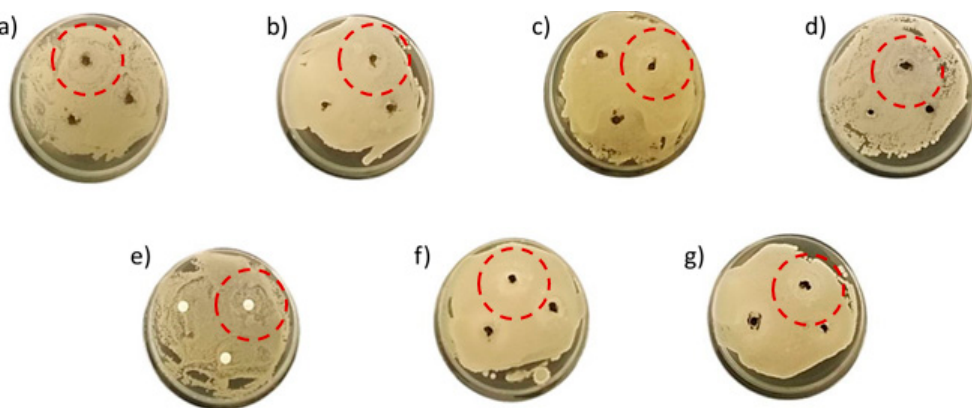
Figure 12. Results of antibacterial studies based on the inhibition zone method for: ( a ) pure detonated nanodiamond particles (DND) with Escherichia coli ; ( b ) DND with Streptococcus mutans ; ( c ) chemically modified detonated nanodiamond particles with hydroxyl functional groups (MDCHPOH) with Pseudomonas aeruginosa ; ( d ) amorphous carbon powder formed using Radio Frequency Plasma Activated Chemical Vapor Deposition Method (RF) with Staphylococcus aureus ; ( e ) fluorescent nanodiamond (MDCHF) with Escherichia coli ; ( f ) Graphene Oxide (GO) film with Pseudomonas aeruginosa ; ( g ) GO film with Streptococcus mutans .